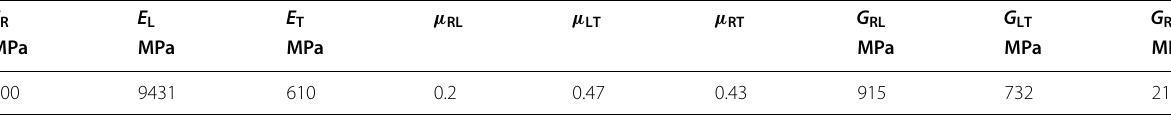
Table 3 Elastic constant parameters of poplar